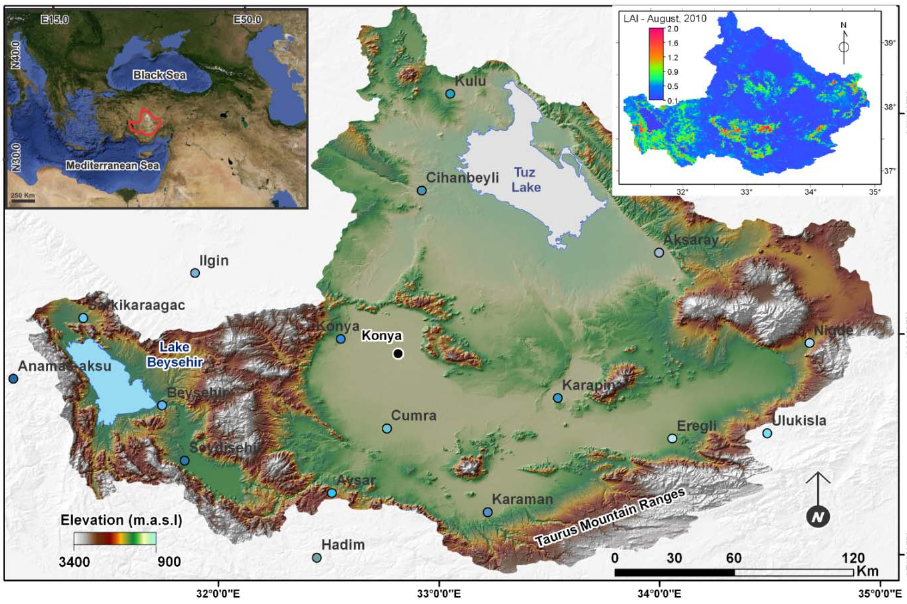
Fig. 1. The geographic location (top left), vegetation distribution (leaf area index map, top right), and SRTM-based elevation map with the locations of the meteorological stations (main panel) of the study area (adapted from Gokmen et al.,